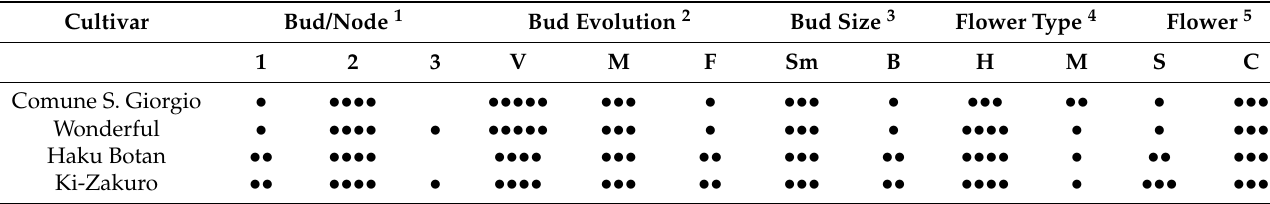
Table 1. Observations in the field of buds and flowers.